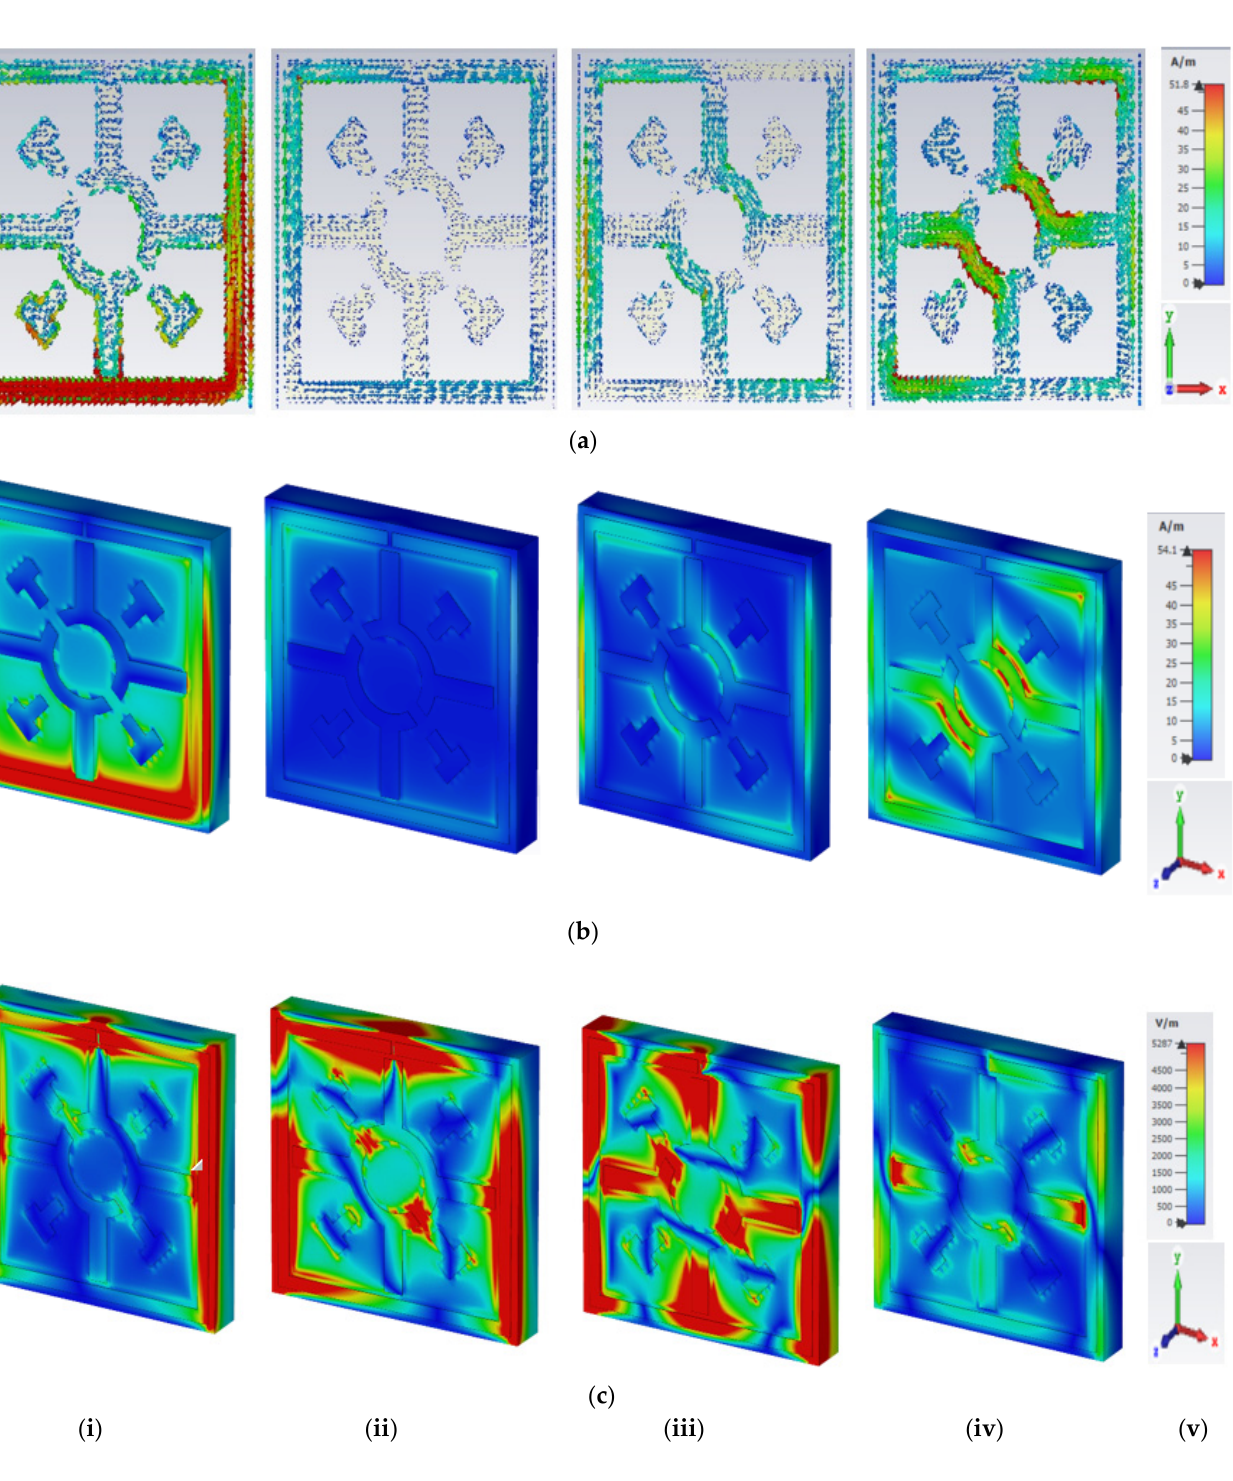
Figure 11. E-field, H-field, and surface current distributions of the Coptic cross shape-based metamaterial unit cell. ( a ) Surface current at top plane, ( b ) magnetic Field (H-field), ( c ) electric Field (E-field), ( i ) 2.02 GHz, ( ii ) 6.985 GHz, ( iii ) 9.985 GHz, ( iv ) 14.425 GHZ, and ( v ) scale and axis.